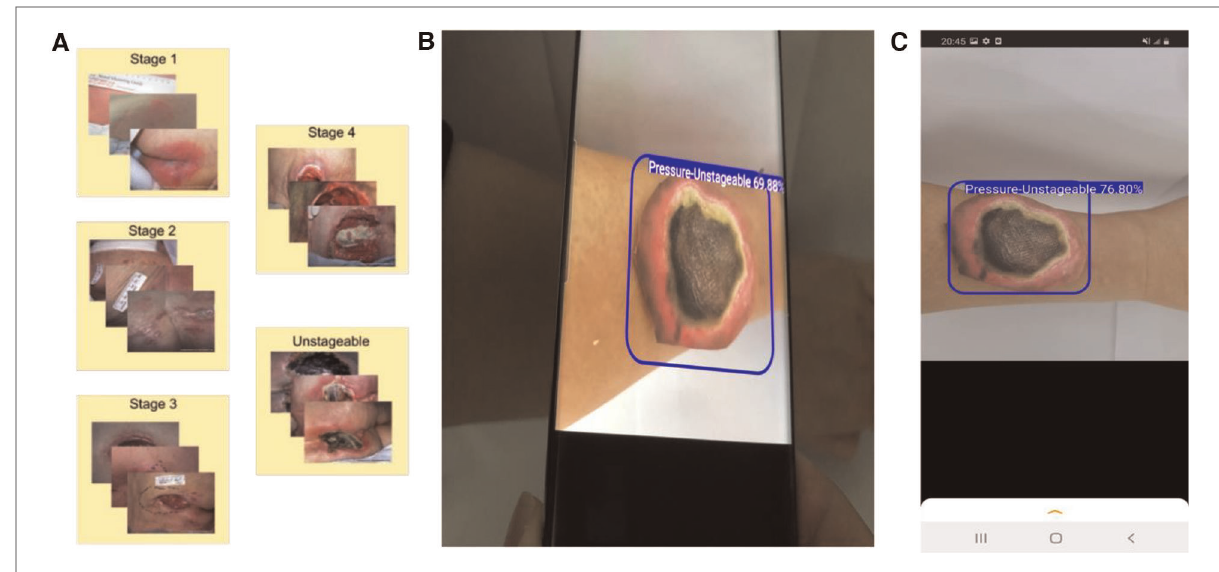
FIGURE 1 Development of a smartphone app for wound assessment. ( A ) Collection and annotation of images of pressure injury wounds. ( B ) Application of our smartphone app to detect and classify PI. ( C ) A screenshot showing how a printed wound image is automatically detected and classi fi ed using the